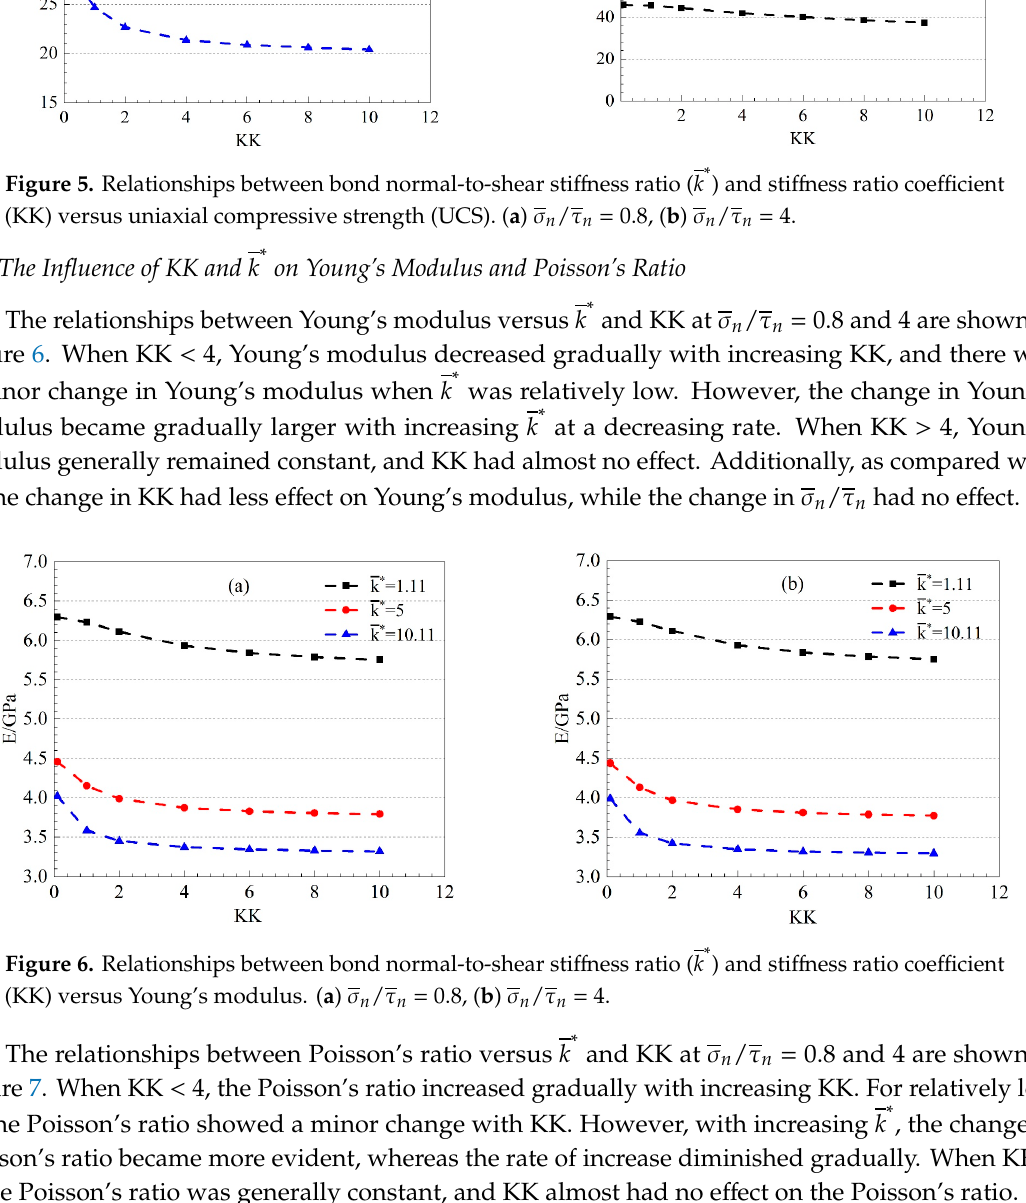
* k ) and stiffness ratio